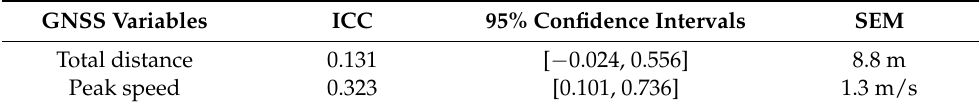
Table 1. Reliability statistical outputs to assess inter-unit consistency.